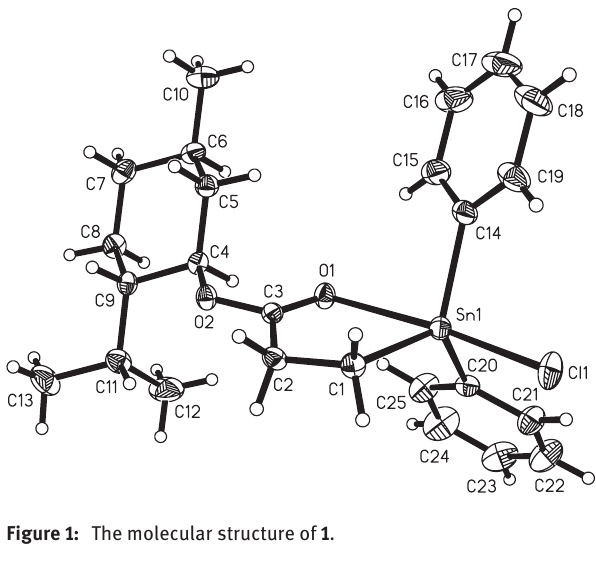
Figure 1: The molecular structure of 1 .